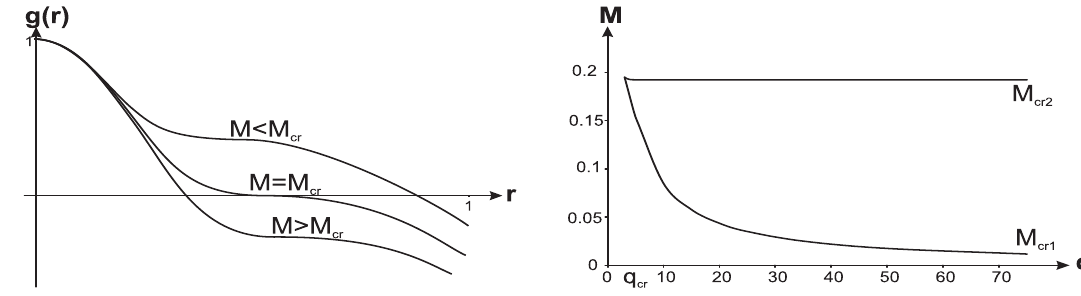
Figure 2. Left: The metric function g ( r ) with the triple horizon ( M = M cr ). Right: Dependence of the critical masses on the parameter q